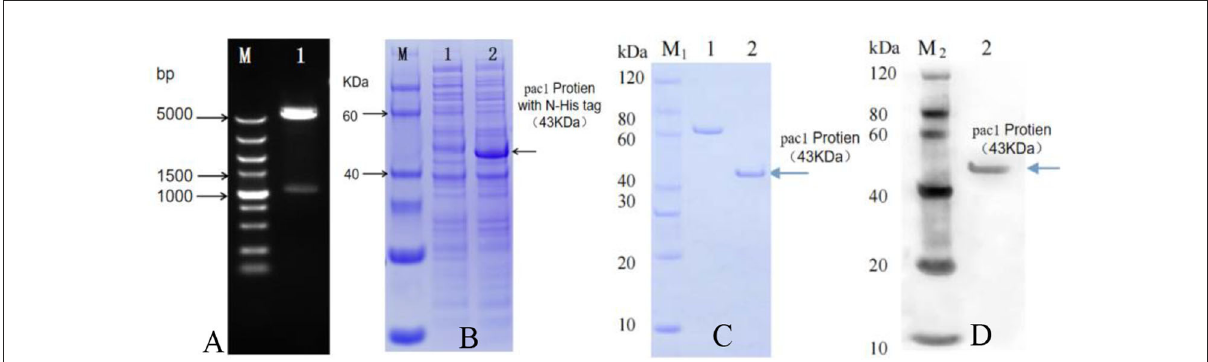
FIGURE1 Pac1 protein prokaryotic expression and purification. (A) pET30a- Pac1 enzyme digestion by Nde I and Hind III. Lane M: DNA maker ladder; Lane 1: pET30a- Pac1 plasmid. (B) Prokaryotic expression of Pac1 protein. Lane M: Protein maker ladder; 1: negative control bacterial cell protein; 2: pET30a- Pac1 bacterial cell protein. (C) Quality assurance of purified Pac1 protein by SDS-PAGE. M1: SDS-PAGE Marker; 1: BSA (1.2 µ g); 2: Pac1 protein (1.2 µ g) purified affinity chromatography (Ni-IDA resin) method. (D) Activity assurance of purified Pac1 protein by Western blot. M2: Western blot marker; 2: purified Pac1 protein (1.2 µ g) interacted with Anti-His Antibody.